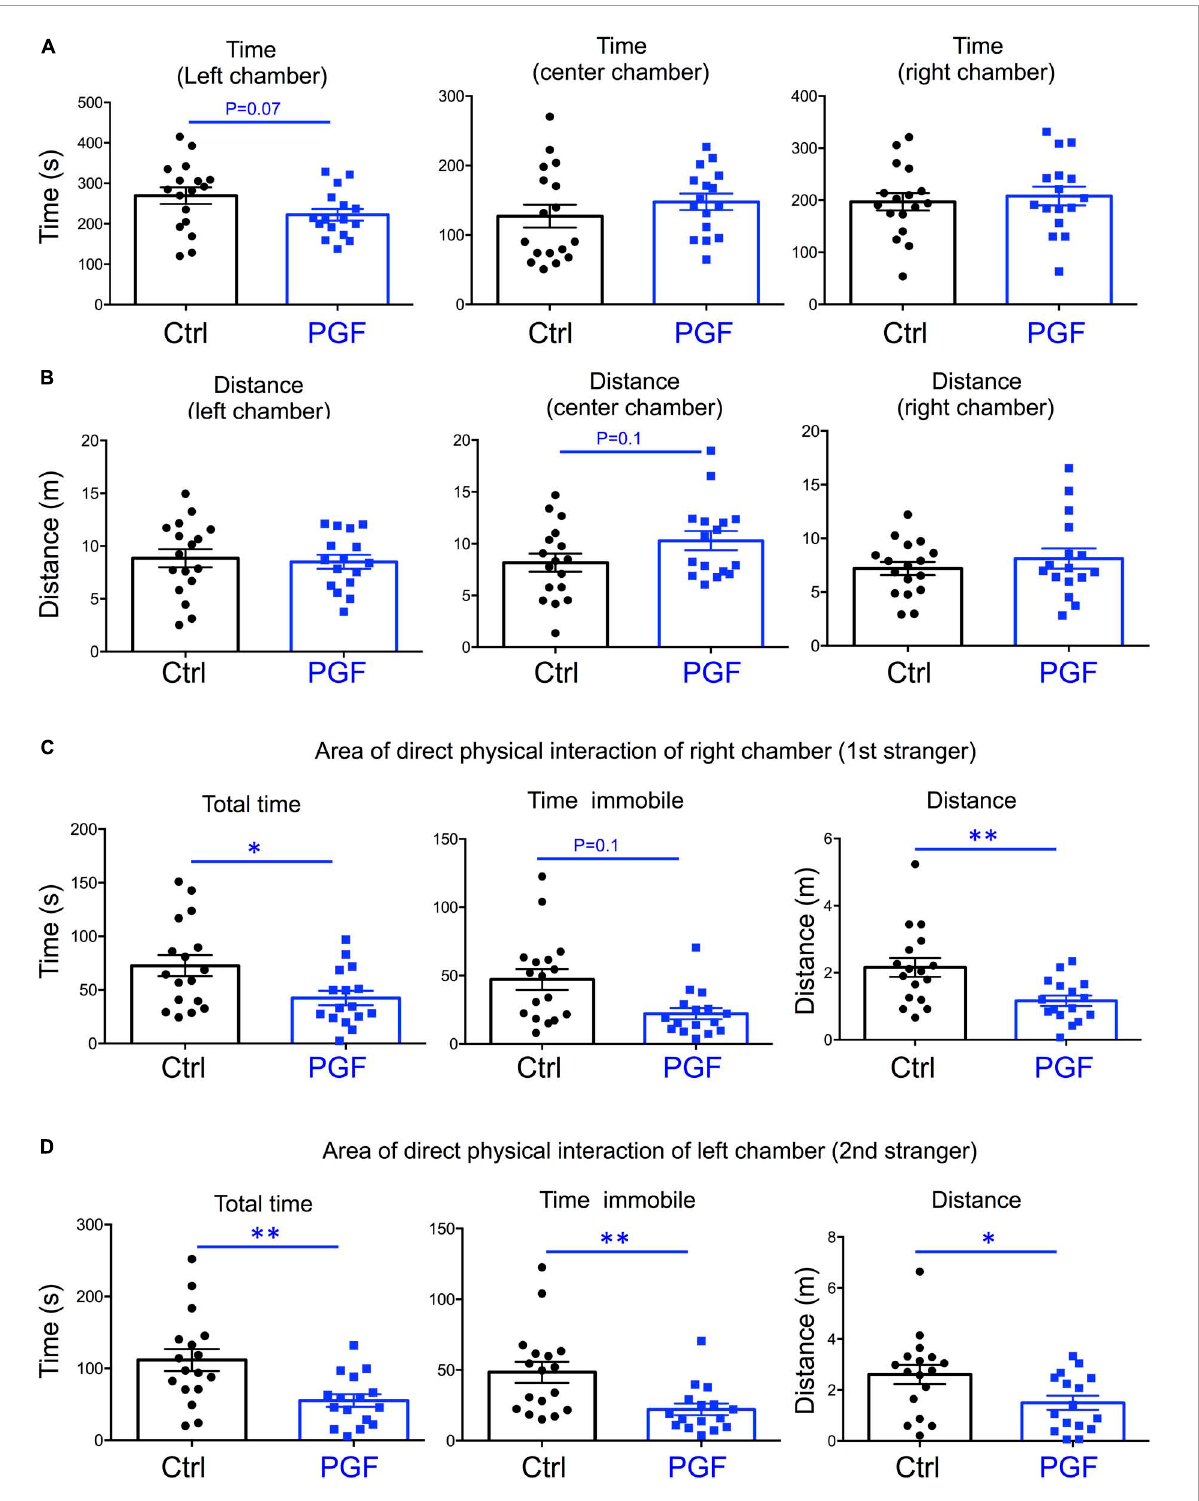
FIGURE4 Interest in social novelty of PGF males. (A–D) Third trial of the three-chamber social box test after a second stranger is added into the left chamber. (A) Time spent by the test mouse in each chamber. (B) Distance traveled by the test mouse in each chamber. (C) Total time, time immobile and distance traveled by the test mouse in the area immediately around the 1st stranger in the right chamber. (D) Total time, time immobile, and distance traveled by the test mouse in the area immediately around the 2nd stranger in the left chamber. Each point represents a different mouse tested at approximately 18 weeks of age ( n = 17, 16) and mean ± SEM are shown. Experimental mice represent 4–7 different litters and data represent two animal cohorts that were generated and tested at different dates. ∗ and ∗∗ indicate P < 0.05 and 0.01, respectively, as determined by the Student’s t